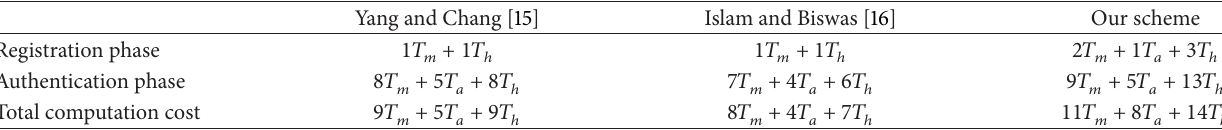
Table 1: Computation cost comparison among our scheme and others. Yang and Chang [15] Islam and Biswas [16] Our scheme